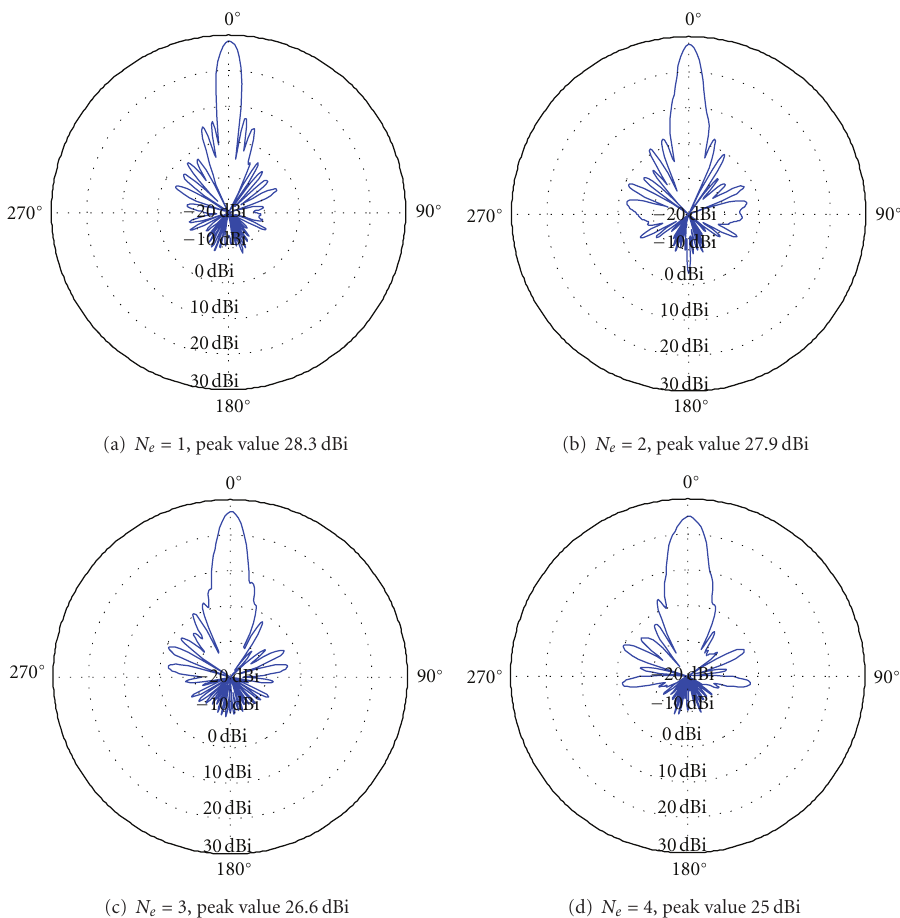
Figure 8: Comparison of radiation patterns with di ff erent N e values at 3 GHz. Peak directivities decrease with larger N e and main lobe widths increase. The parameter L in (1) is set to be 350mm. The other values except N x = N y = N e remain